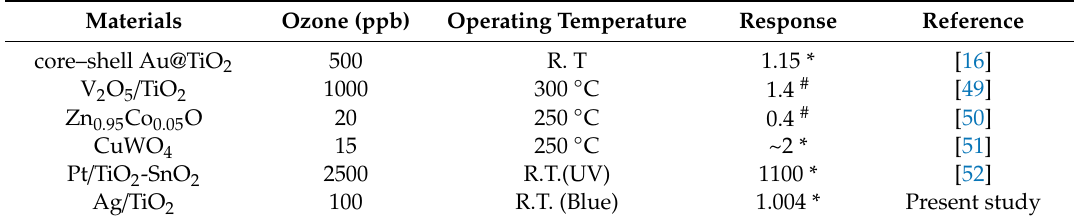
Table 3. The response of ozone using different materials ( R. T: Room temperature, * S = R g /R air , # S = (R g - Rair)/Rair) .